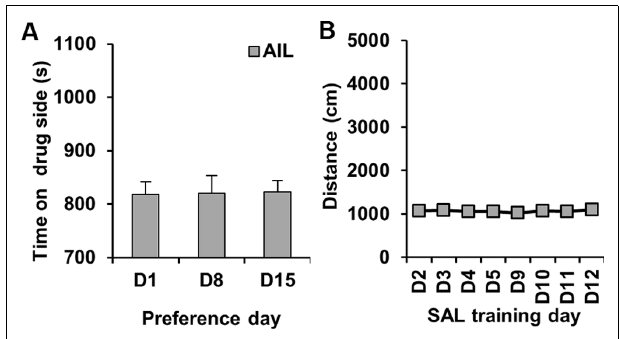
FIGURE 3 | Preference and locomotor activity in a SAL control experiment inAIL mice. (A) Time spent on the drug (left)-paired side on D1 and on D8 and D15 following training with SAL administration in both sides of the CPP apparatus in AIL mice ( N = 32). (B) Locomotor activity (centimeter) during the training trials where mice received SAL each day (D2–D5; D9–D12).